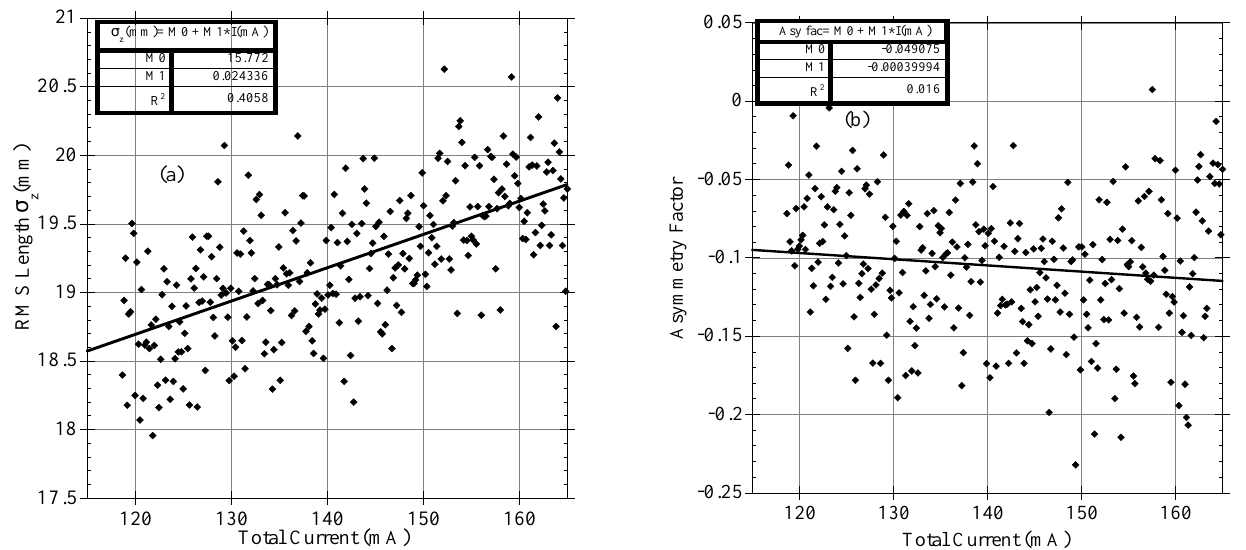
FIG. 10. (a) The positron bunch length and (b) asymmetry factor as a function of current during high-energy collisions in CESR. The bunch length and asymmetry factor are fit to a line. The rf accelerating voltage during the measurement was 6.42 6 0.01 MV.